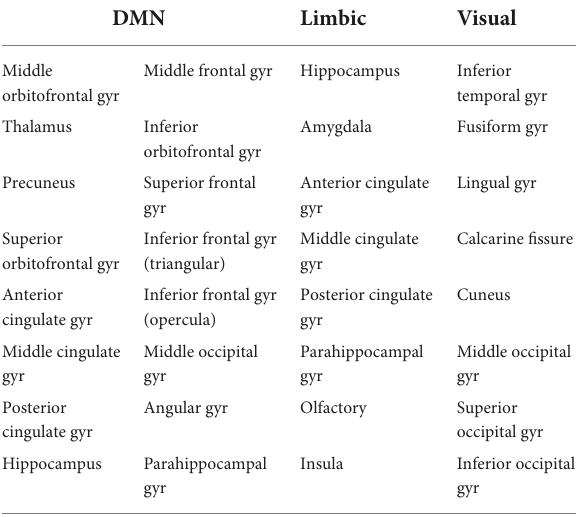
TABLE 1 Nodes of the AAL atlas included in the DMN, limbic and visual subnetworks. The nodes from both the left and right hemispheres are